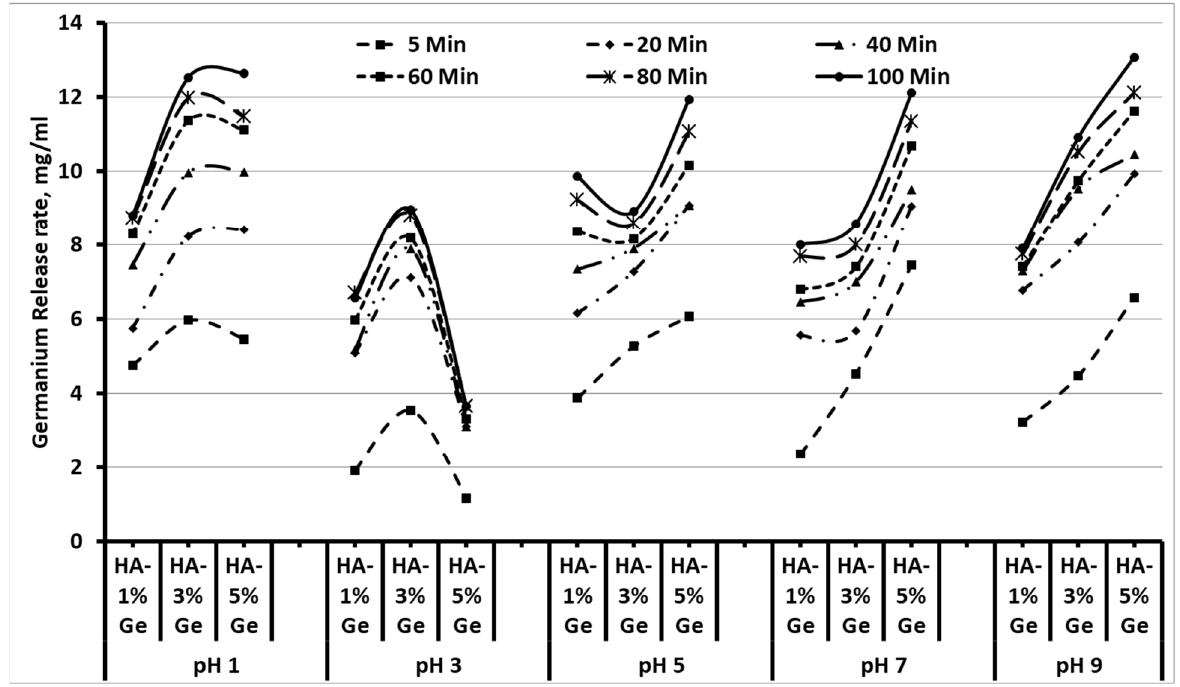
Figure 4. Drug-releasing pattern of HA-Ge biomaterials in different pH. HA-1% Ge-HA with 1% germanium, HA-3% Ge-HA with 3% germanium, and HA-5% Ge-HA with 5% germanium.